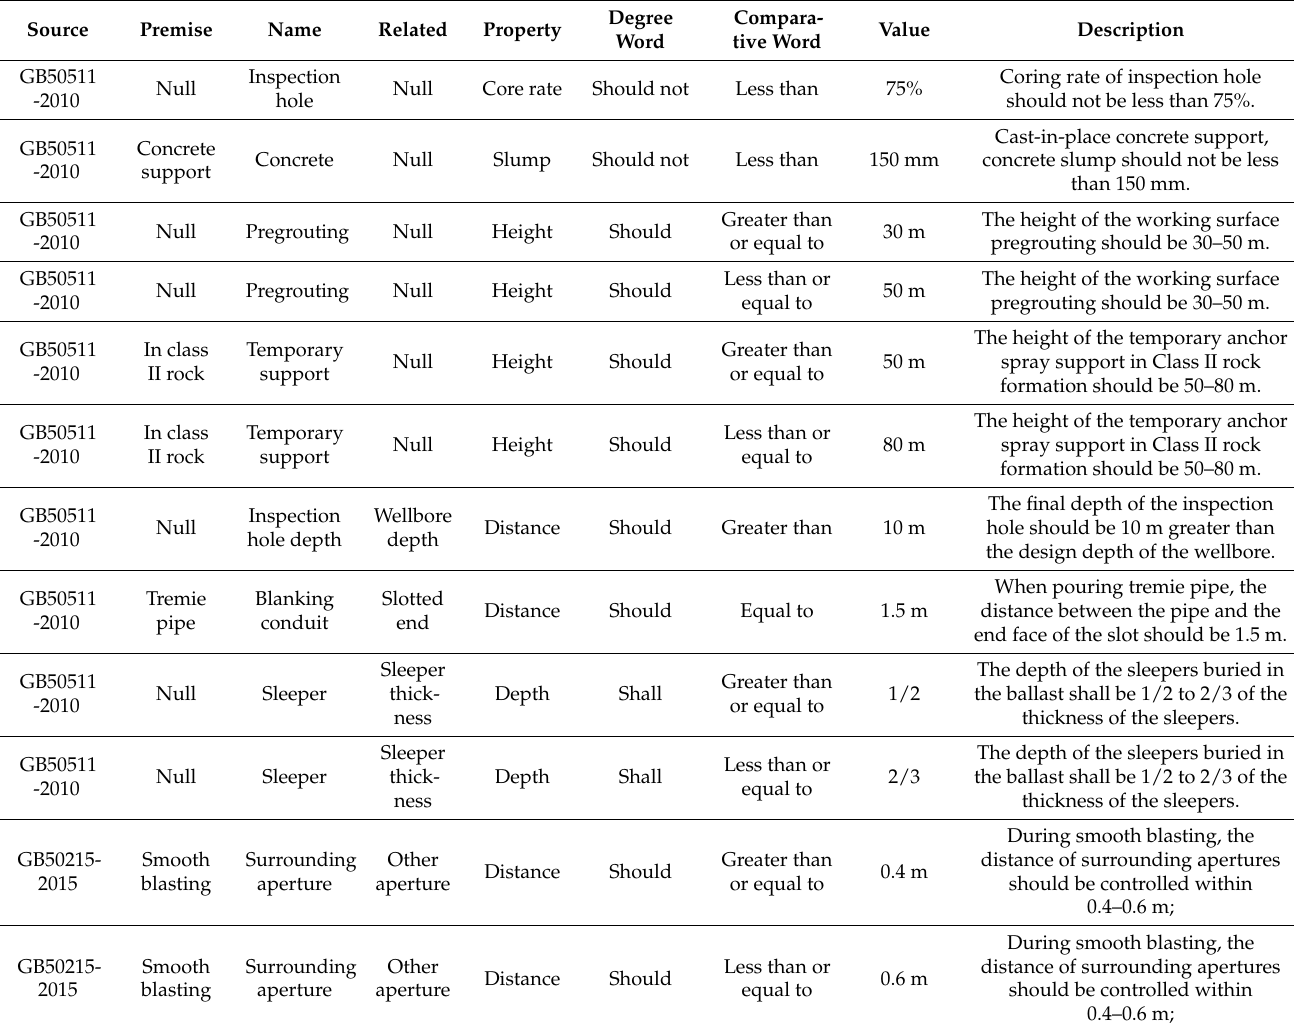
Table 3. Standardization framework for building